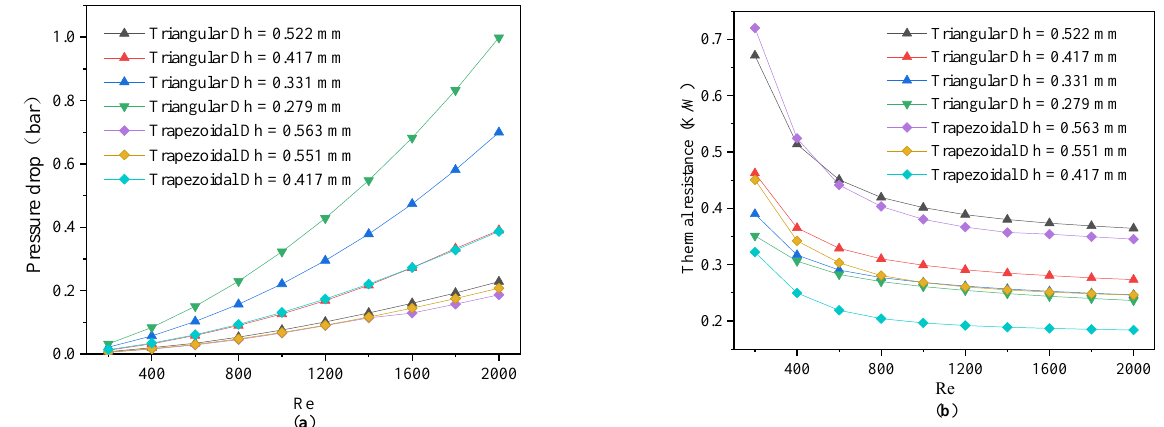
Figure 9. The variation of pressure drop ( a ) and thermal resistance ( b ) with different Reynolds numbers for triangular and trapezoidal microchannel heat sinks.